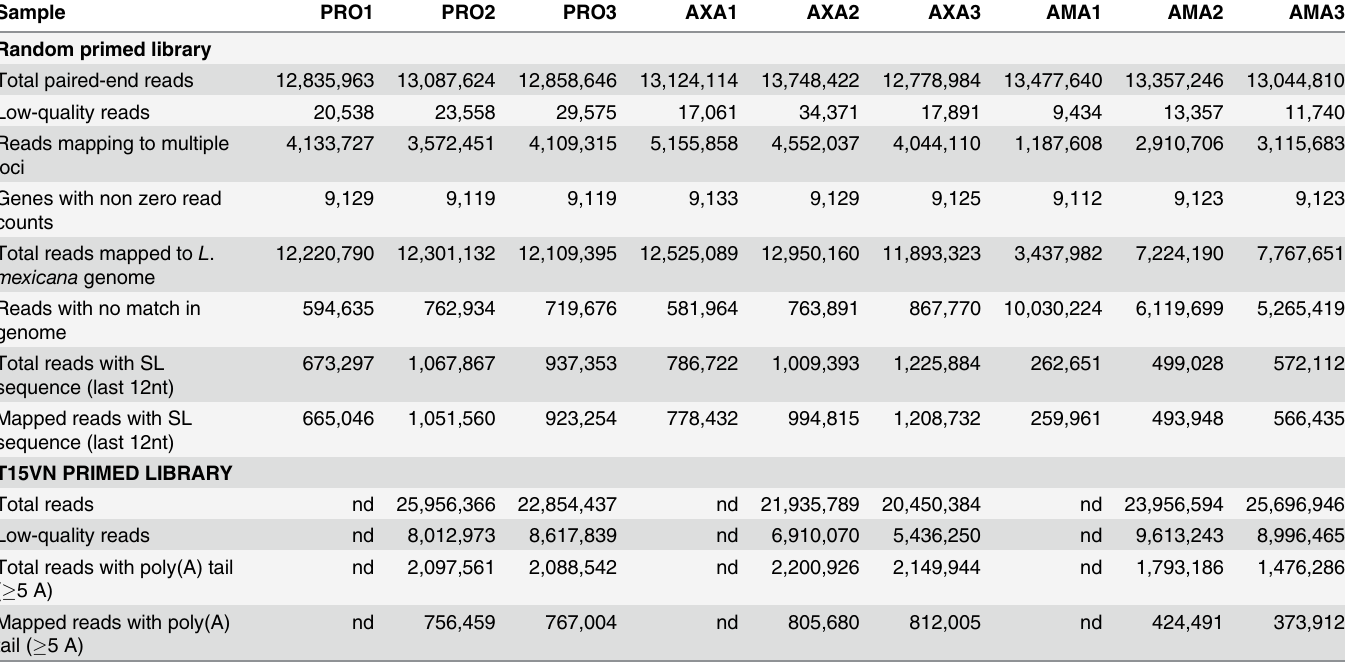
Table 2. RNA-seq read mapping summary.